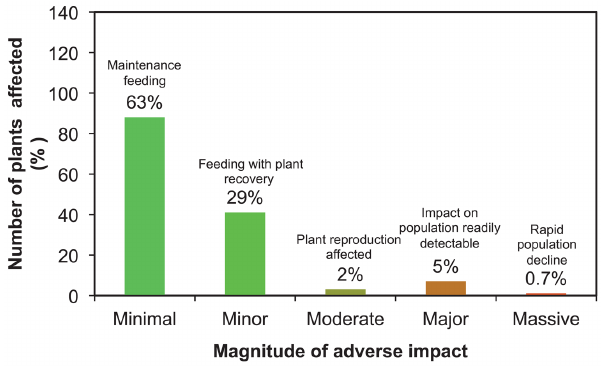
Figure 3. Number of plant taxa with non-target impacts from weed biological control agents, by